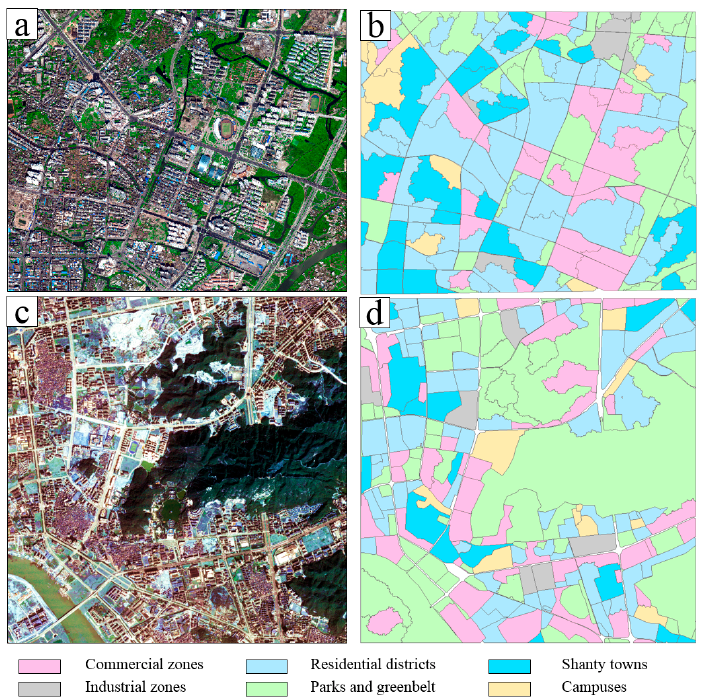
Figure 19. Geoscene segmentation results of the two study areas: ( a , c ) the original QuickBird images of Putian and Zhuhai and ( b , d ) their segmentation results.